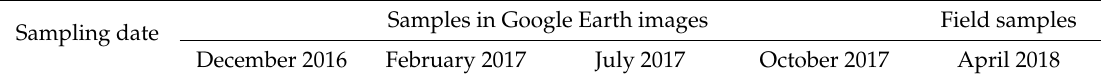
Figure 4. Partial samples in the Google Earth images. Table 4. Acquisition dates of